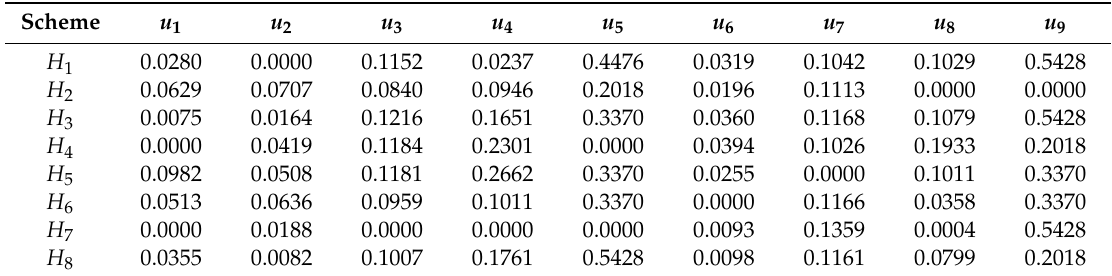
Table 4. Distance from attribute information of each scheme to H + .